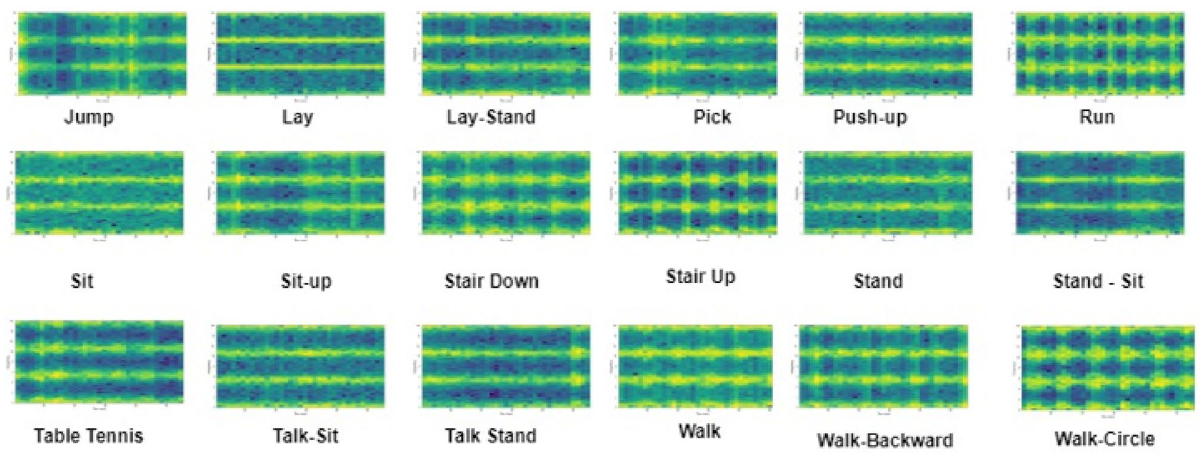
Figure 7. Spectrogram images for various human activities from the KU-HAR dataset.